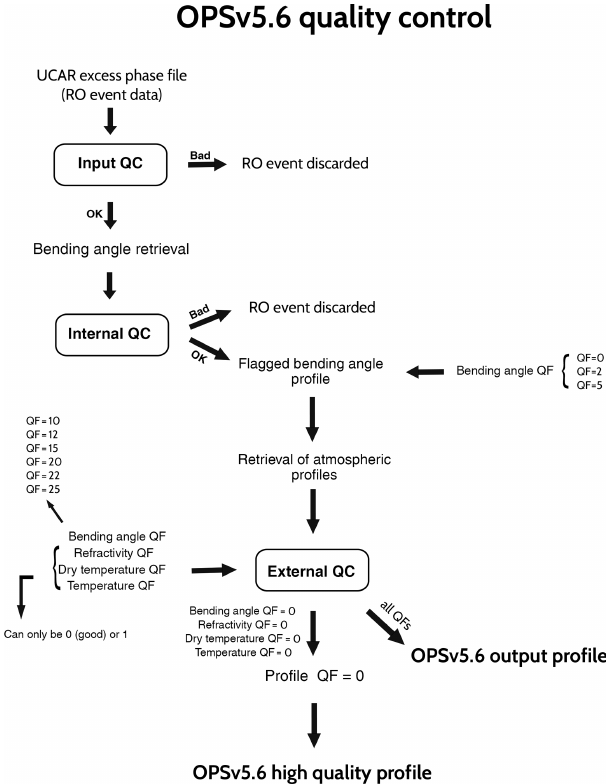
Figure 1. Schematic representation of the quality control approach of the WEGC OPSv5.6